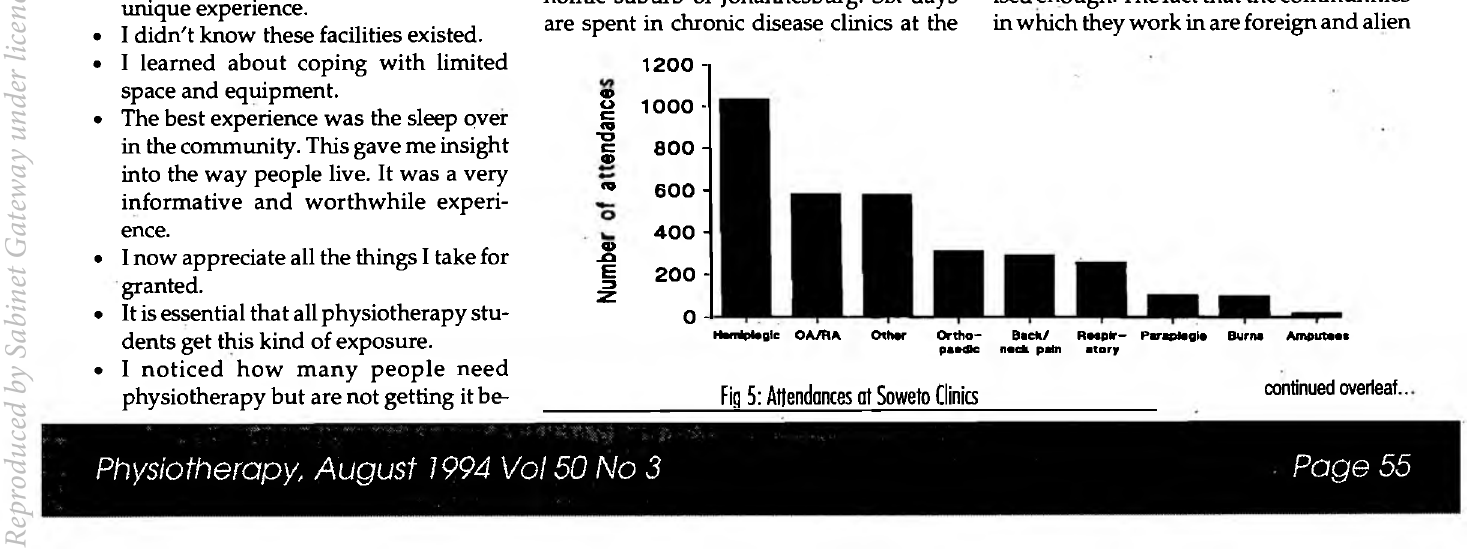
Fig 3: Was able to work well with physiotherapy assislants Student responses have generally been